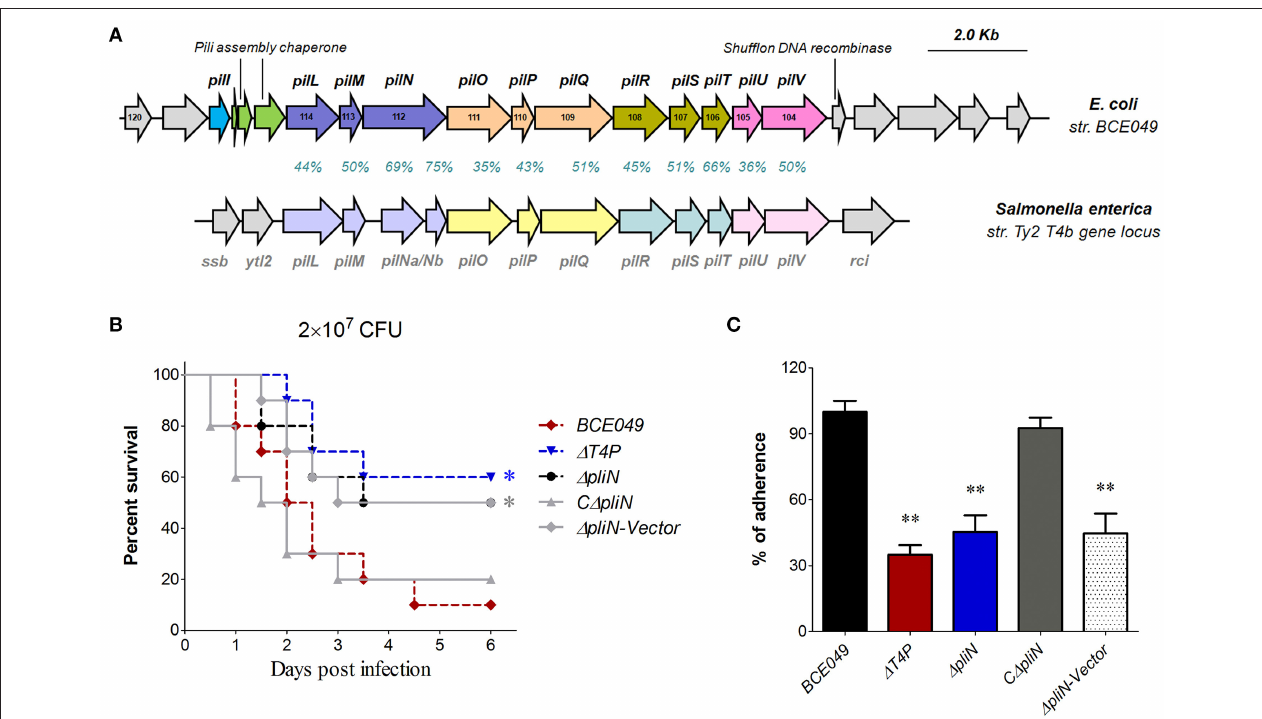
FIGURE 6 | Identification of a plasmid-encoding T4P involved in bacterial virulence. (A) Schematic diagram for the genetic organization of T4P loci from E. coli strain BCE049 and Salmonella enterica strain Ty2. The identity and similarity of amino acid sequences for each gene in T4P loci are shown. (B) Effect of T4P and PliN on ExPEC BCE049 pathogenicity. Survival curve of mice infected with 2 × 10 7 CFU/mouse bacteria (10 5-week-old mice per group). The data were compared with that of strain BCE049 and analyzed using the log-rank (Mantel–Cox) test (* P < 0.05). (C) HeLa cells adhesion assay. All assays were run in triplicate. Statistical significance was determined by Student t -test (** P <